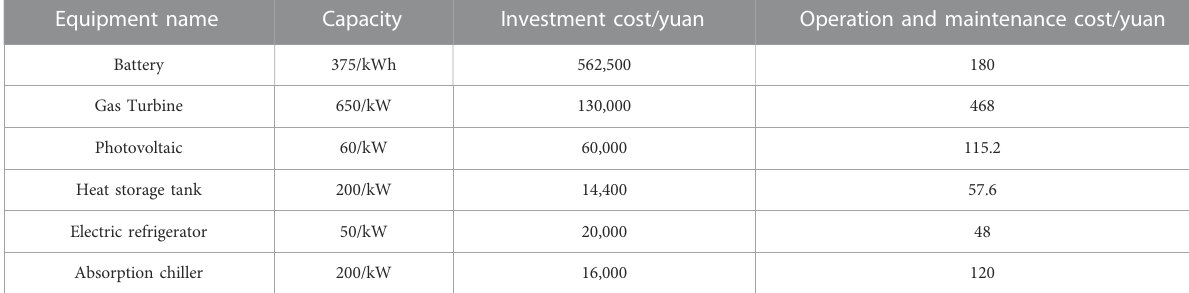
TABLE 2 Optimization results of building microgrid system for Case